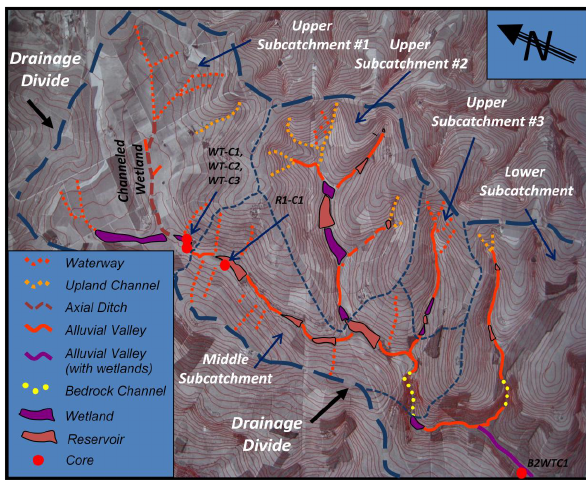
Fig. 5. Delineation of process zones and subcatchment areas within the upper and middle subcatchments.